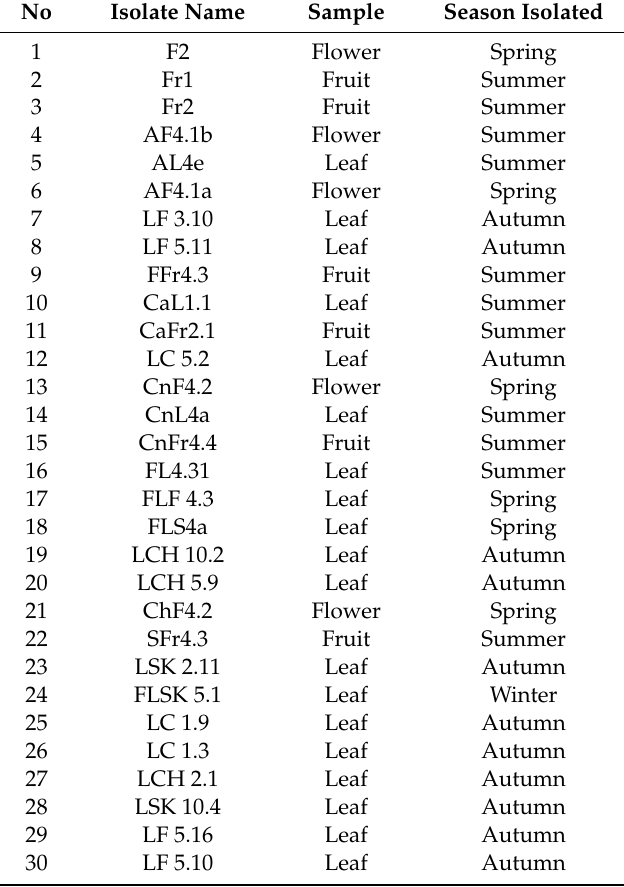
Table 3. The 30 isolates of A. pullulans , with sample sources and times of sampling, used for quantifying the MIC 50 for CPN, CYP, and DFN All the isolates were identified based on the ITS sequence, which resulted in the SH number SH1515060.08FU. Isolates FLSK5.1, ChF4.2, and LF5.10 were identified by MALDI-TOF